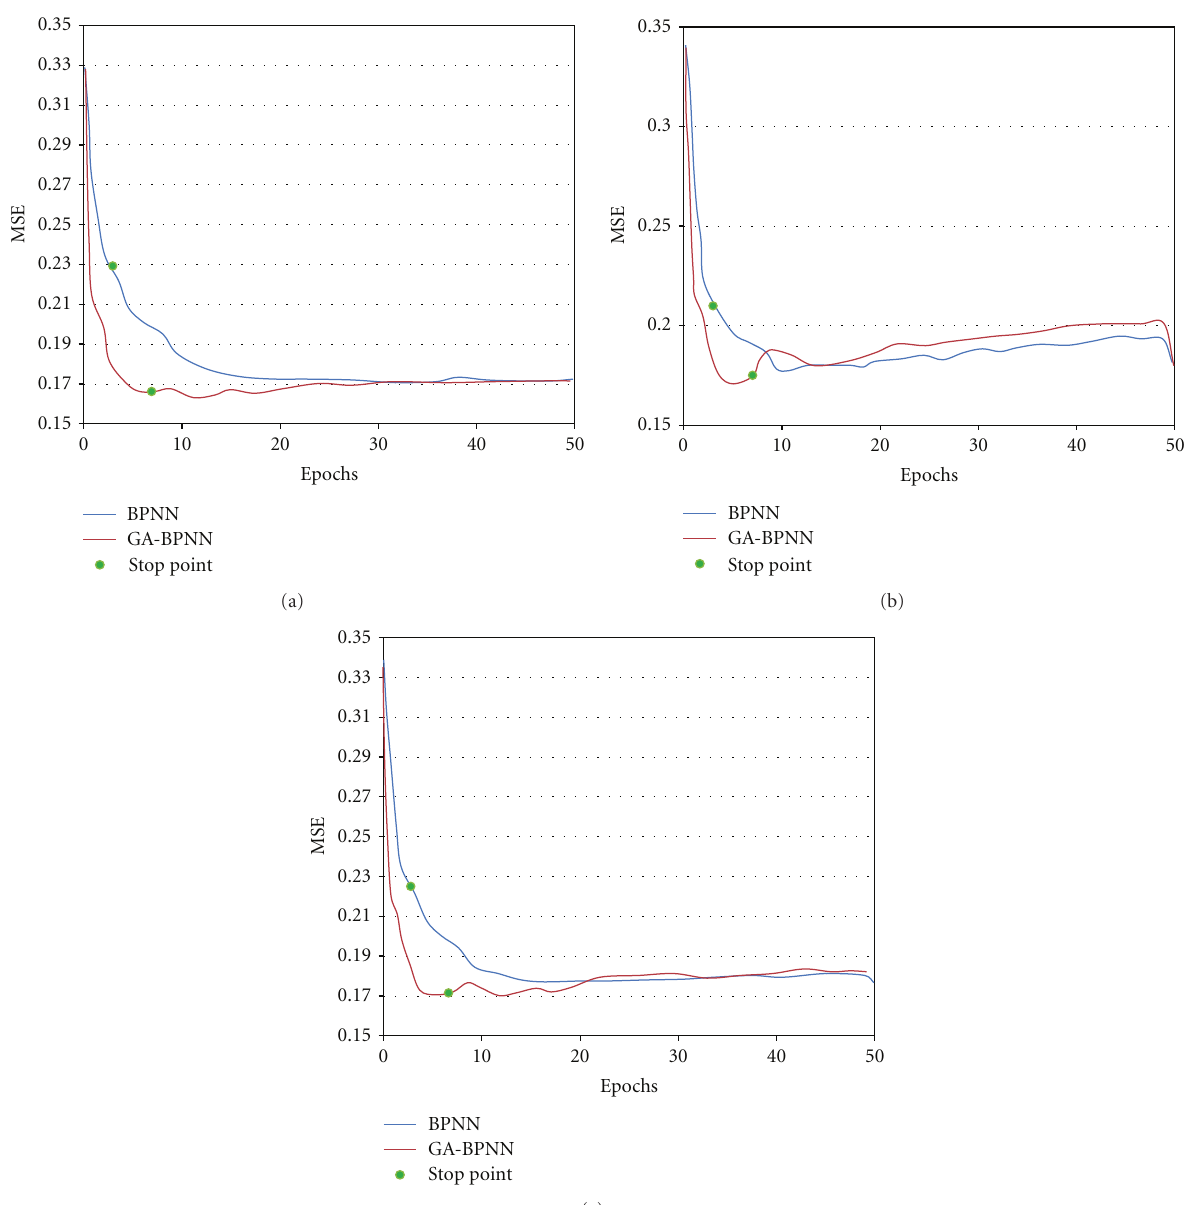
Figure 4: Comparison of the MSE between BPNN and GA-based BPNN for di ff erent data: (a) training data, (b) testing data, (c) database (including training and testing